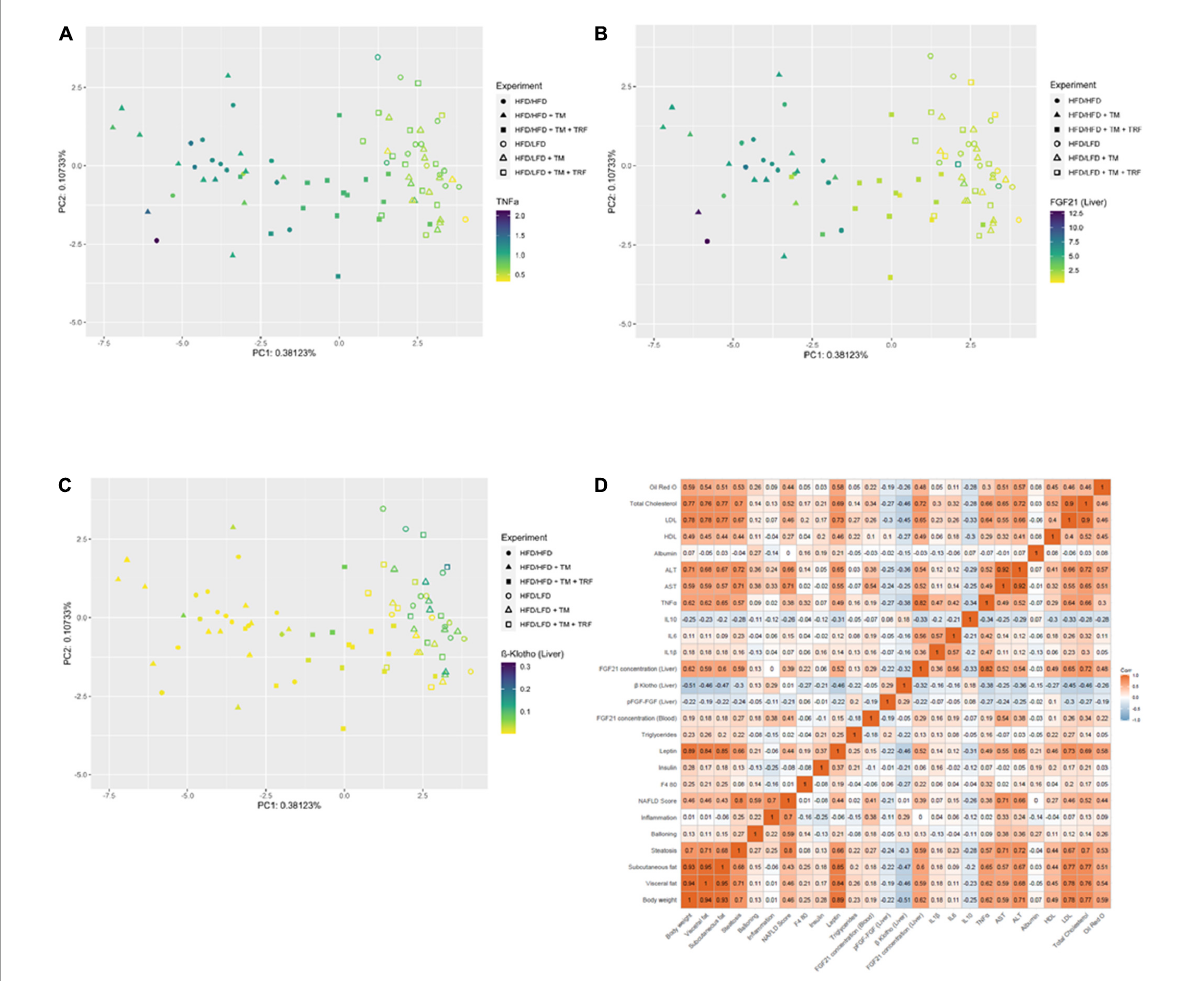
FIGURE6 Dot plot of principal component analysis (PCA) for TNF α (A) , FGF21 in the liver (B) , and β -klotho in the liver (C) and correlation (Pearson, two-sided test, statistical significance was set at p < 0.05) represented as a multidimensional heatmap (D) . All parameters from previously acquired experiments were further used for PCA construction. TNF α ( A: HFD/HFD n = 13, HFD/HFD + TM n = 13, HFD/HFD + TM + TRF n = 15, HFD/LFD n = 14, HFD/LFD + TM n = 15, HFD/LFD + TM + TRF n = 14; total n = 84), FGF21 liver ( B: HFD/HFD n = 13, HFD/HFD + TM n = 13, HFD/HFD + TM + TRF n = 15, HFD/LFD n = 14, HFD/LFD + TM n = 15, HFD/LFD + TM + TRF n = 14; total n = 84), and β -klotho liver ( C: HFD/HFD n = 13, HFD/HFD + TM n = 13, HFD/HFD + TM + TRF n = 15, HFD/LFD n = 14, HFD/LFD + TM n = 15, HFD/LFD + TM + TRF n = 14; total n = 84). In panels A–C , filled circles, triangles, and squares represent groups with HFD, and non-filled indicate dietary change to LFD. In panel D , red color indicates positive correlation, blue color indicates negative correlation, while white indicates no correlation. HFD, high-fat diet; LFD, low-fat diet; TM, treadmill; TRF, time-restricted